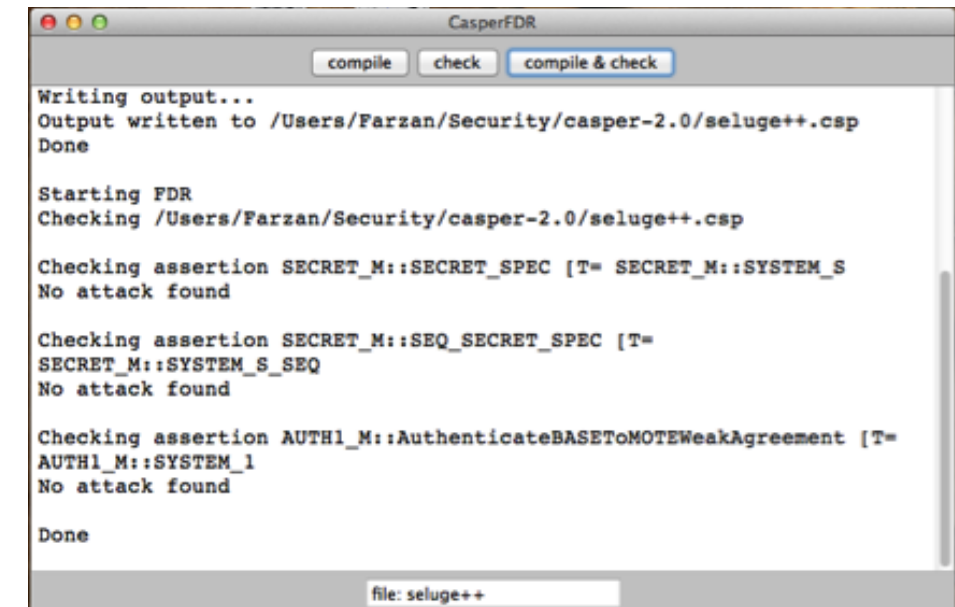
Figure 8. The FDR2 (Failures-Divergence Refinement) results of Seluge++ key generation in